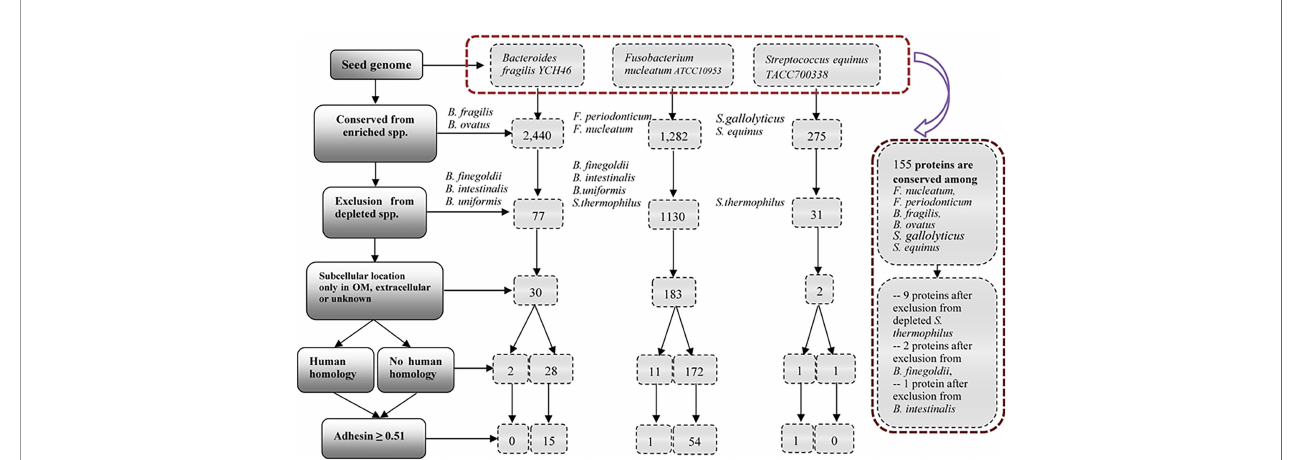
FIGURE 3 | Vaxign analysis overall work fl ow and related results. The overall project work fl ow and related results were shown in Figure 3 . In the group of Bacteroides , B. fragilis YCH46 was used as seed genome. RM predicted 30 proteins, including two proteins with human homology and 28 proteins without human homology. In the group of Streptococcus , S. equinus TACC700338 was used as seed genome, and predicted one human homology proteins, and one proteins without human homology. In the group of Fusobacterium , F. nucleatum ATCC10953 was used as seed genome, and compared with the increased and decreased genomes of the group of Bacteroides and Streptococcus . 54 proteins without human homology and 11 human homology proteins were identi fi ed. Finally, F. nucleatum ATCC10953 as seed genome, compared with 25 enriched genomes of F.nucleatum , F. periodonticum , B. fragilis , B.ovatus , S.gallolyticus , and S. equinus , and 155 proteins were conserved among all the enriched species. Exclusion from depleted genomes of S. thermophilus , B. fi negoldii and B. intestinalis , we obtained nine proteins, two proteins and one proteins,